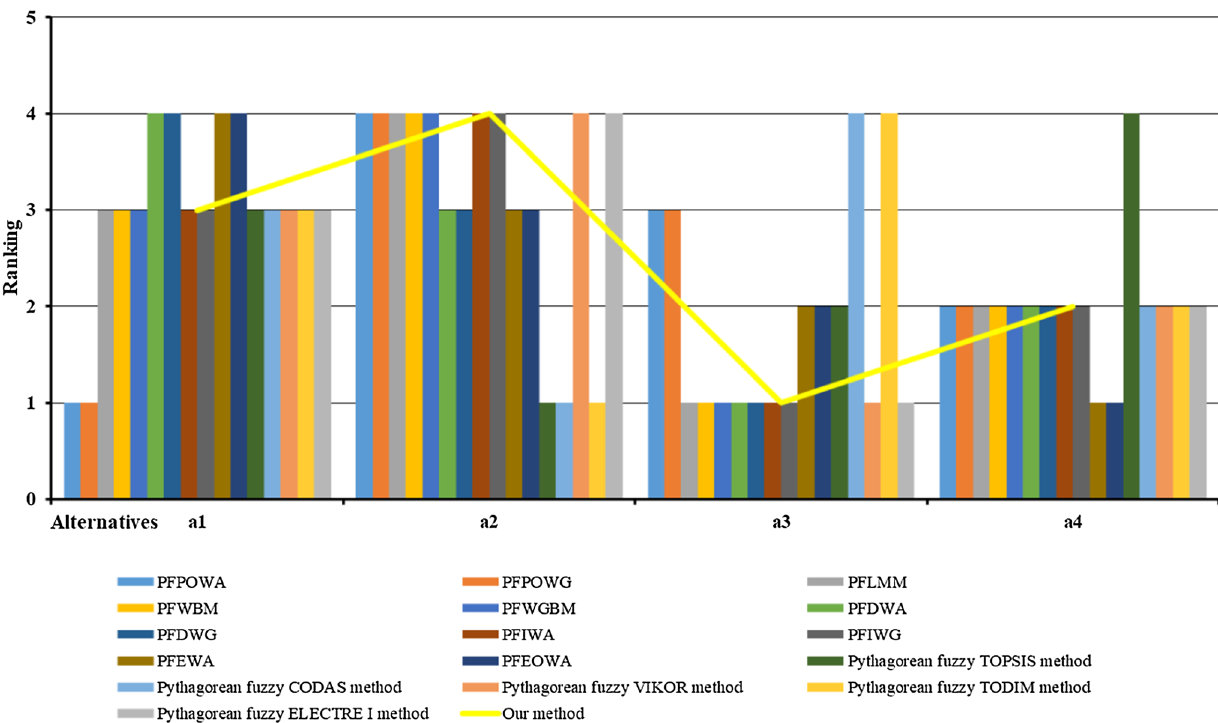
Fig. 8 Comparison of alternative rankings with different Pythagorean fuzzy MCDM